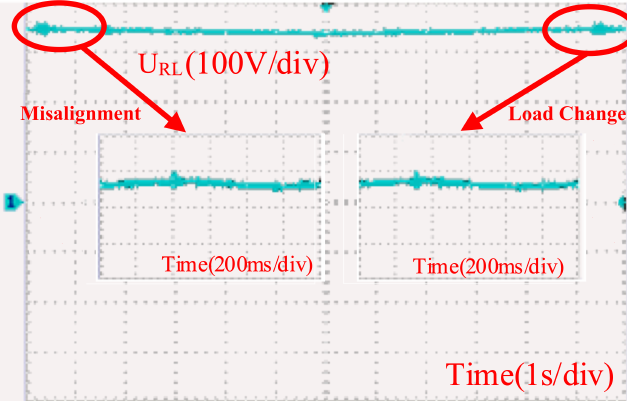
Figure 17. Receiver voltage change.